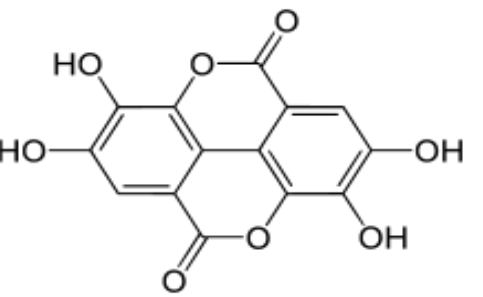
Figure 2 Chemical Structure of Ellagic acid (2,3,7,8- Tetrahydroxy[1]benzopyrano[5,4,3-cde][1]benzopyran-